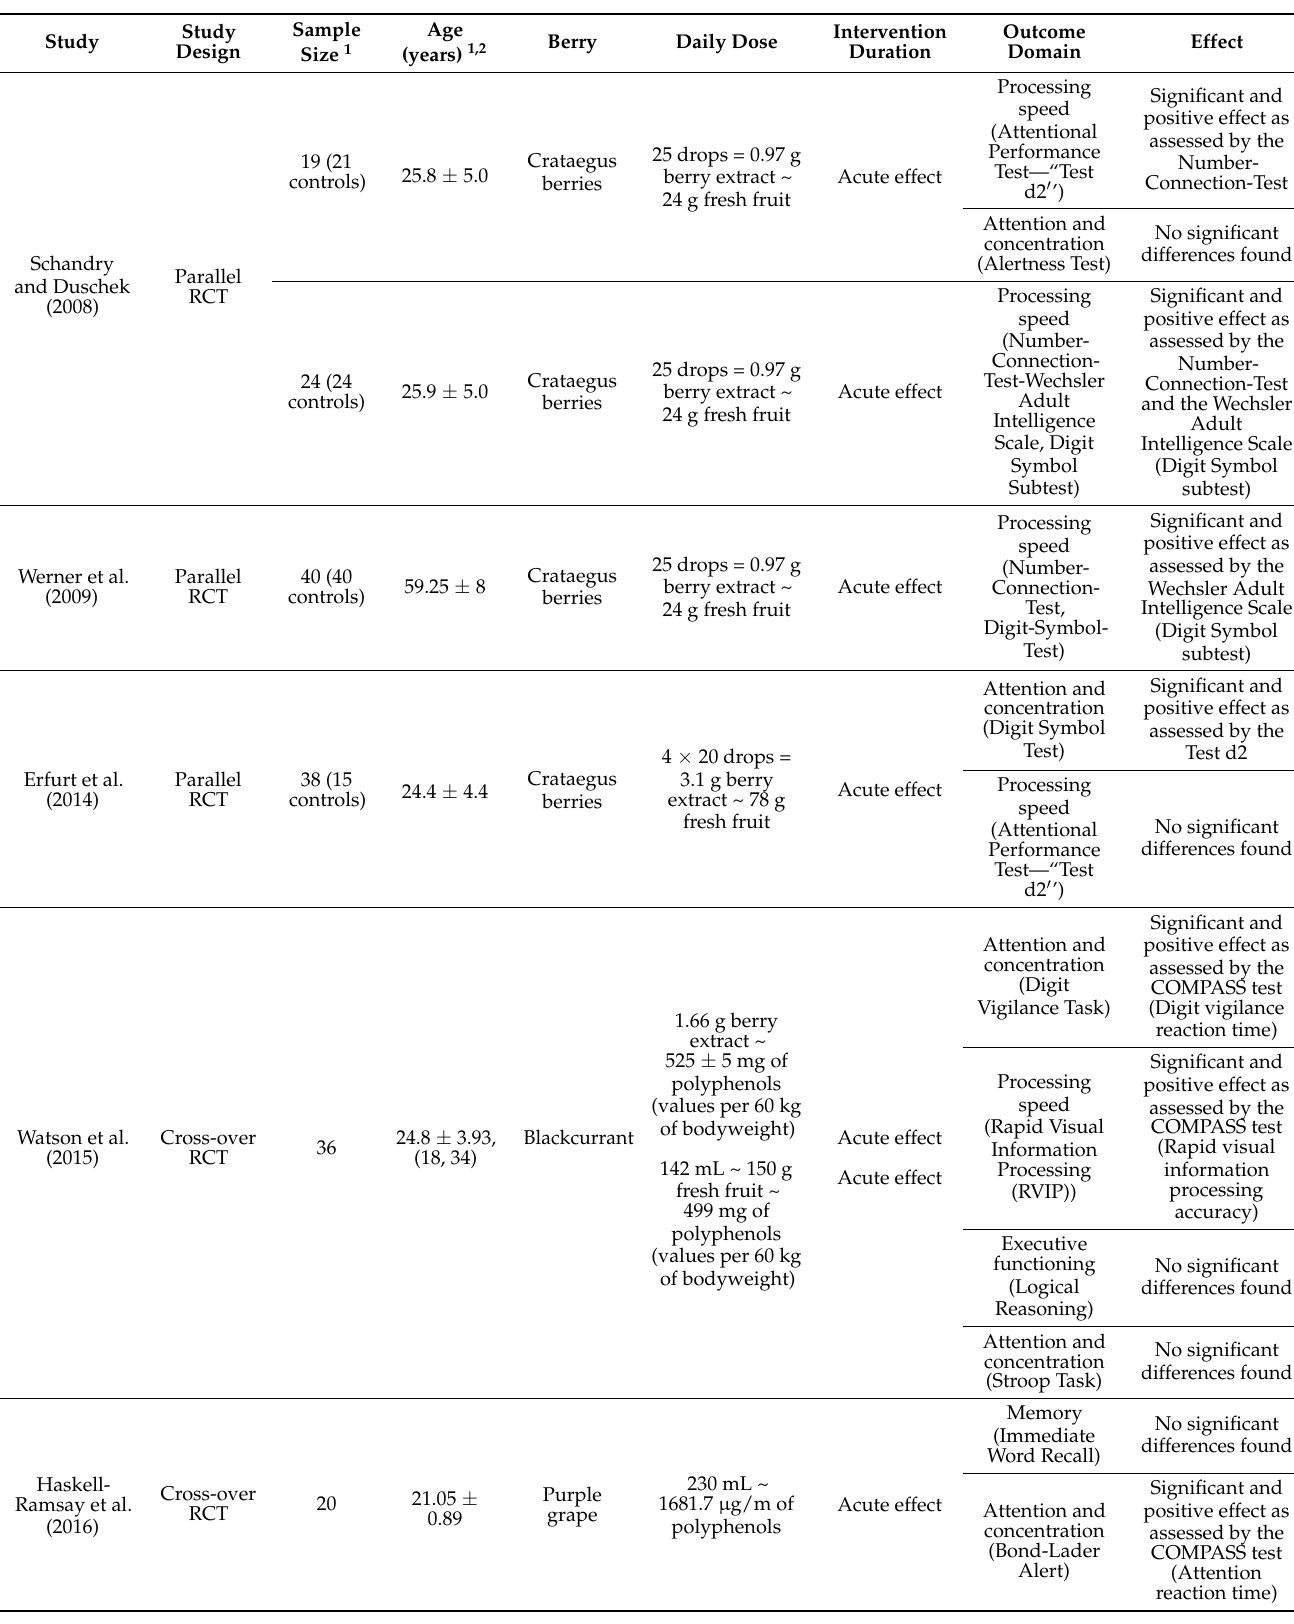
Table 1. Characteristics of the selected studies